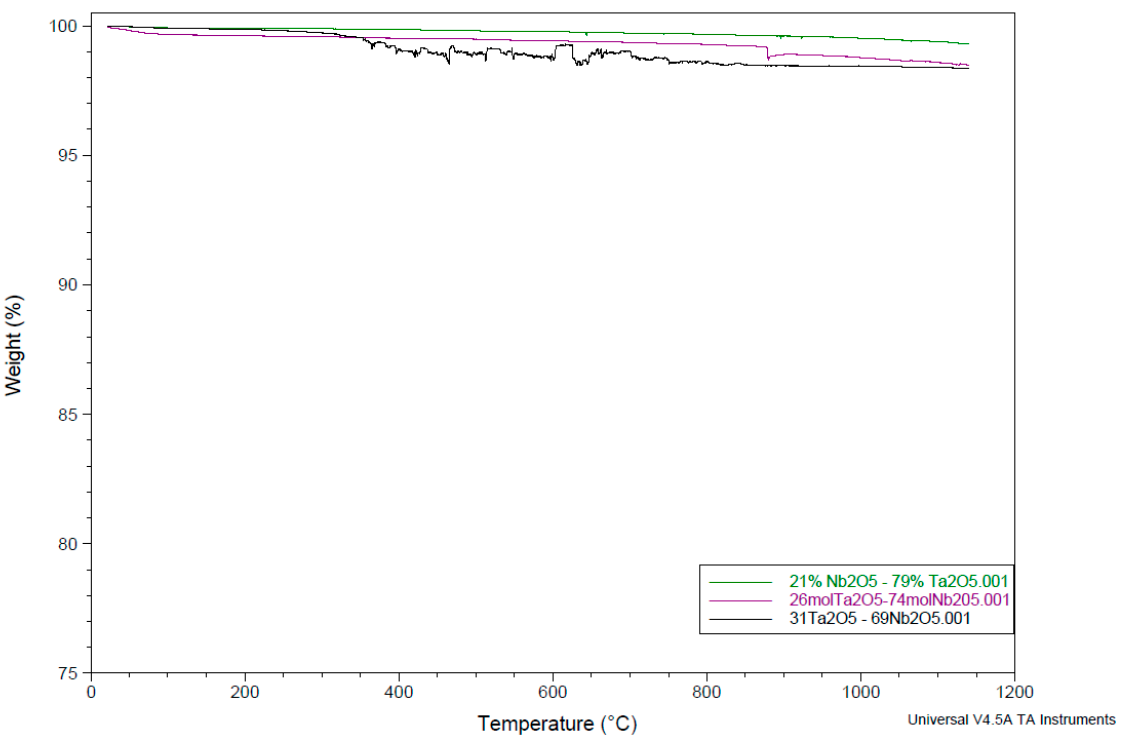
Figure 2. TGA scans of three Ta 2 O 5 -Nb 2 O 5 compositions (green: 21 Ta 2 O 5 to 79 Nb 2 O 5 ; violet: 31 Ta 2 O 5 to 69 Nb 2 O 5 ; grey: 26 Ta 2 O 5 to 74 Nb 2 O 5 ; all concentrations are in mol%) showing weight loss